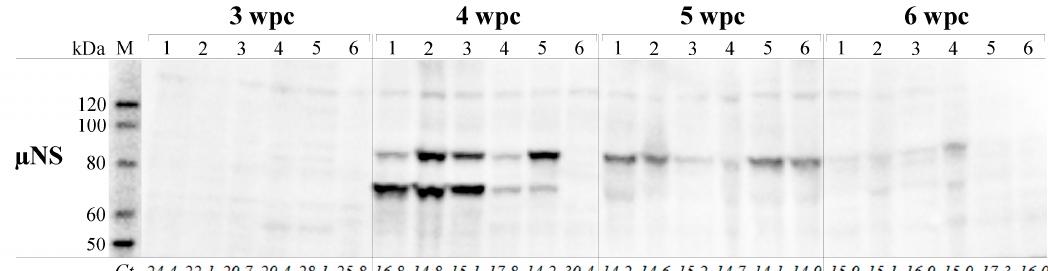
Figure 5. Detection of PRV uNS protein in blood cells compared to viral RNA load. Blood cells from 3, 4, 5 and 6 wpc ( n = 6) analyzed for µ NS by Western blotting. Ct-values for gene segment M3 ( µ NS) from the same samples are shown below each lane. M = molecular weight standard; Lane 1–6 refers to individual fish (1–6) per time point.